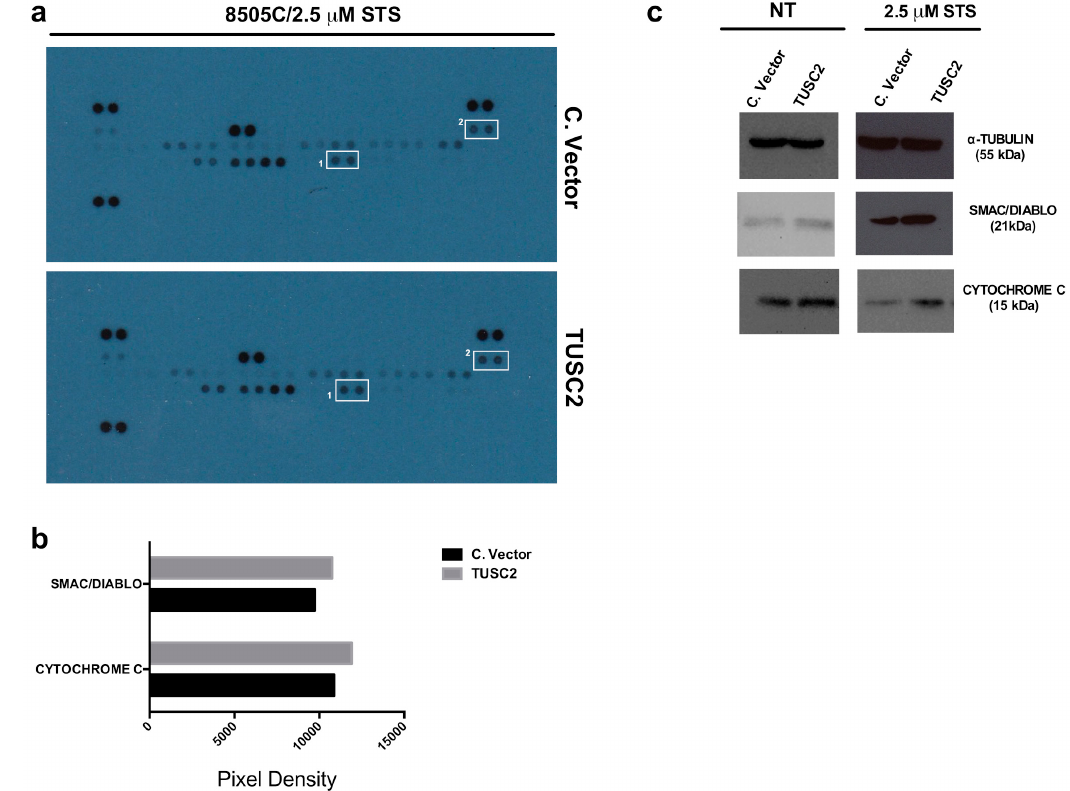
Figure 5. TUSC2 forced expression increased SMAC / DIABLO and CYTOCHROME C protein levels. ( a ) 8505C cells stably transfected with TUSC2 or with Control Vector (C. Vector) were treated for 24 h with 2.5 µ M STS, and then 400 µ g of protein lysates were blotted on the Proteome Profiler Human Apoptosis Array nitrocellulose membrane purchased from R&D Systems. Spots highlighted and labelled as #1 refer to SMAC / DIABLO and as #2 refer to CYTOCHROME C proteins.( b ) Quantification of pixel intensities was performed with the ImageJ software programme (version 1.50i) and each protein is represented as the average signal (pixel density) of a pair of duplicate spots. Pixel density was normalized by subtracting the average background signal. ( c ) Western blot for SMAC / DIABLO, CYTOCHROME C and TUBULIN proteins in an independent cell lysate of transfected 8505C cells untreated (NT) or treated with STS.